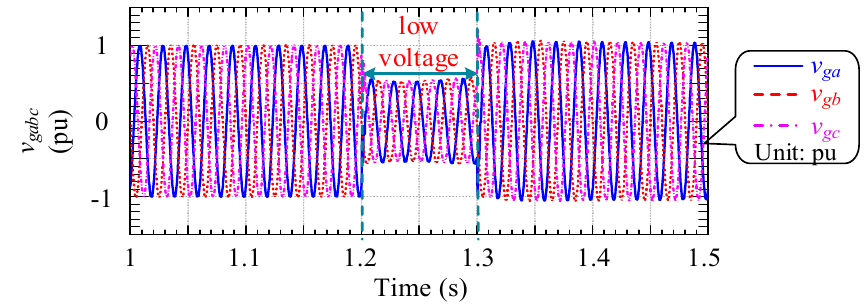
Figure 16. Three-phase grid voltages with a low voltage period from t = 1.2 s–1.3 s.